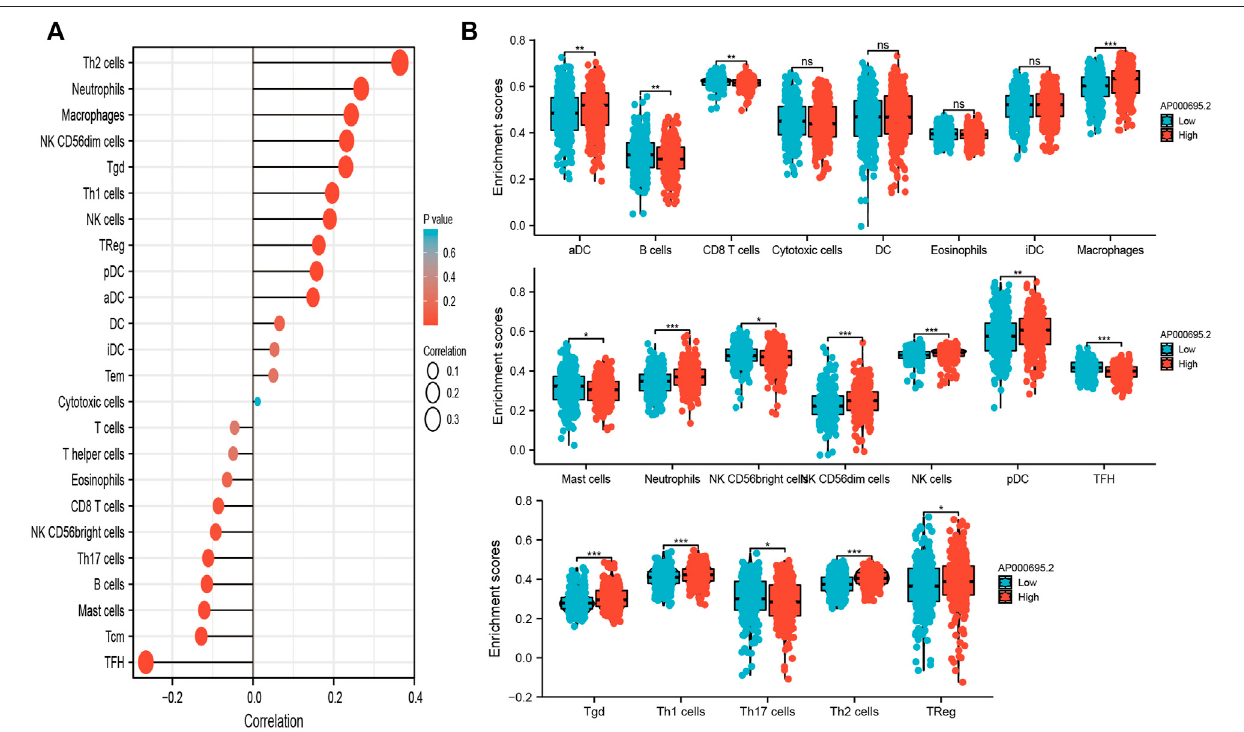
FIGURE 7 | Correlation analysis of lncRNA-AP000695.2 expression and in fi ltration levels of immune cells in LUAD tissues. (A) Correlation between the relative abundances of 24 immune cells and lncRNA AP000695.2 expression level. (B) Box plots of the correlations between lncRNA-AP000695.2 or molecular model expression and in fi ltration levels of immune cells. * p < 0.05, ** p < 0.01, and *** p <